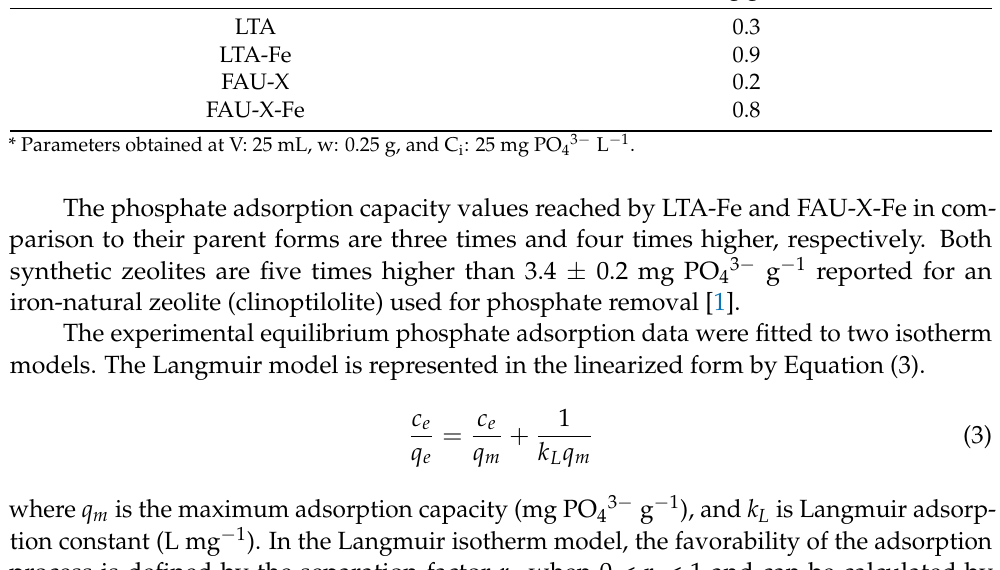
Table 3. Comparative phosphate adsorption on LTA-Fe and FAU-X-Fe and their parent forms.